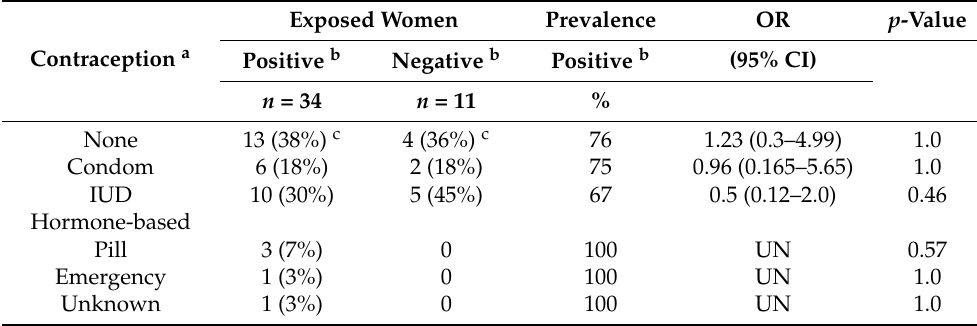
Table 3. Contraception methods and prevalence of Neisseria gonorrhoeae culture-positivity among exposed